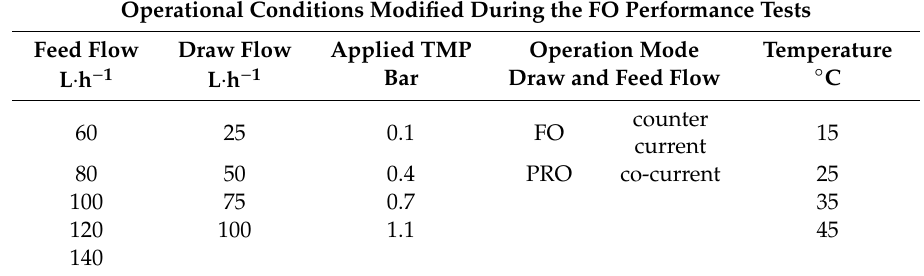
Table 2. Operational parameters modified during FO tests. PRO, pressure retarded osmosis.